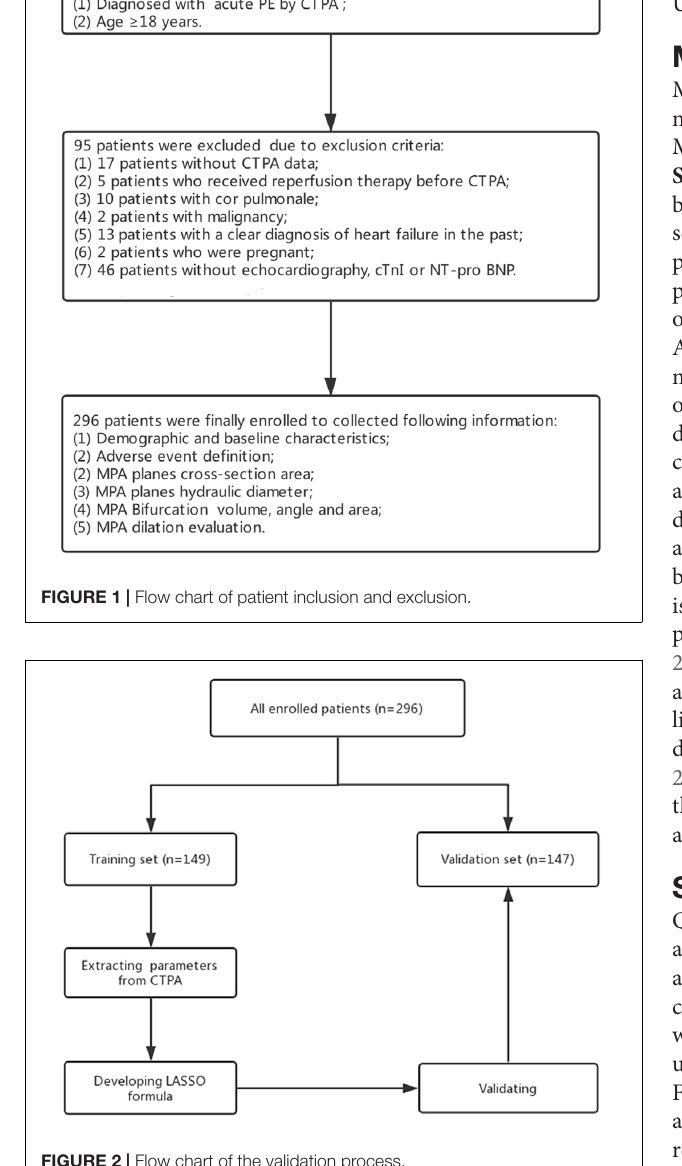
BNP ( + ) was defined as NT-pro BNP ≥ 600 pg/ml (normal range ≤ 300 pg/ml); otherwise, patients were classified as NT-pro BNP ( − ) (Konstantinides et al.,